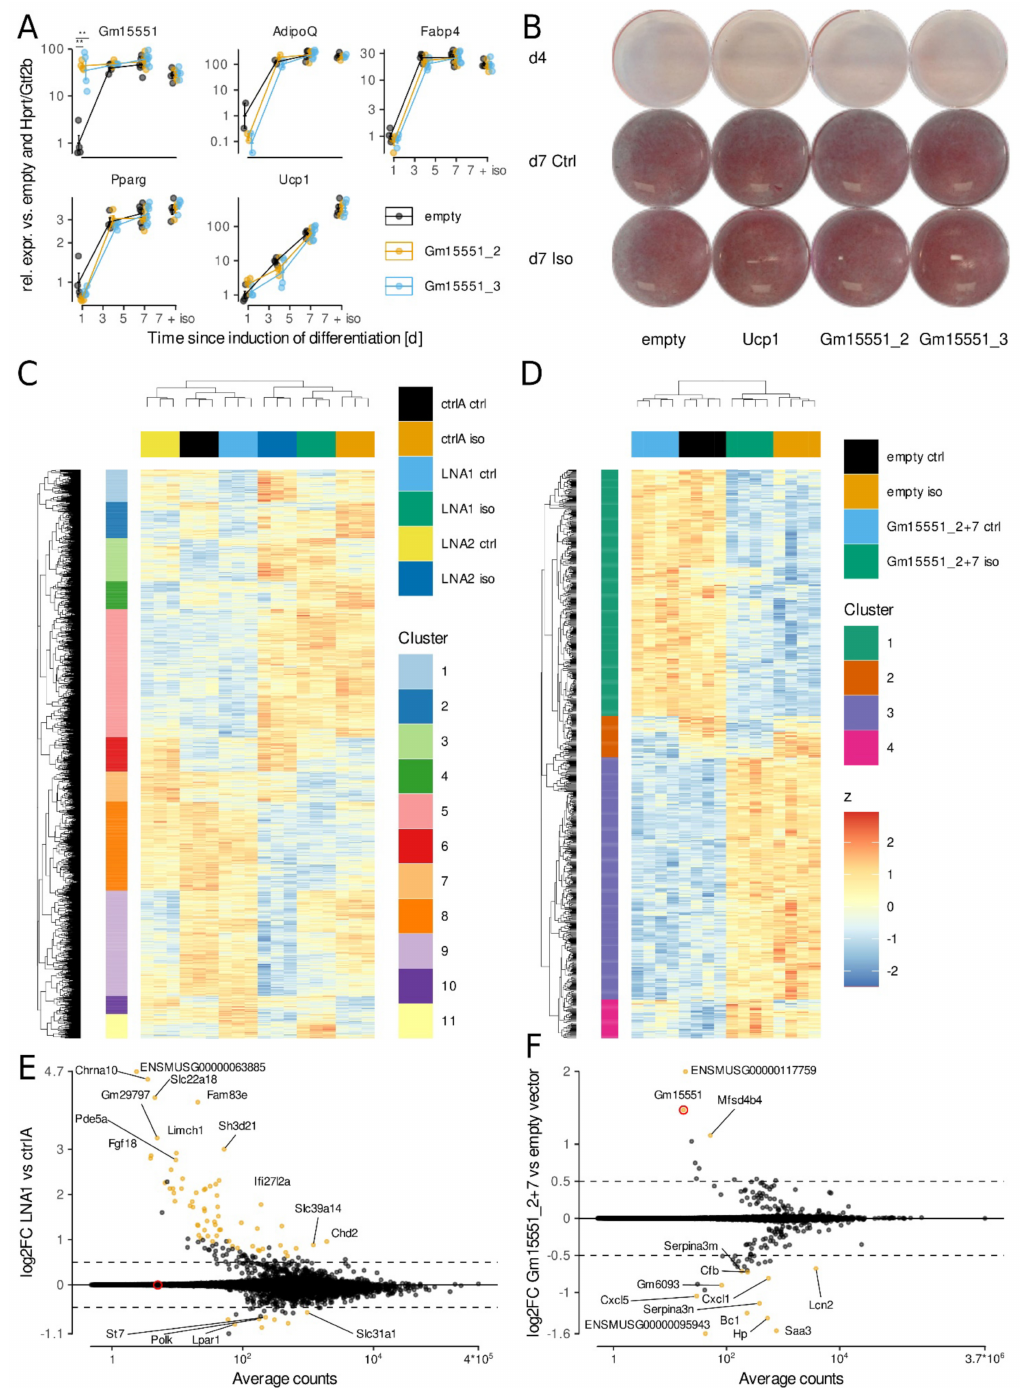
Figure 3. Gm15551 is dispensable for iBAT function in vitro. ( A , B ) Gene expression profiles ( A ) of Gm15551 , the common adipocyte marker genes Pparg , Adipoq and Fabp4 as well as the brown adipocyte marker gene Ucp1 (paired t -test, n = 2–6) and oil red O staining ( B ) of wt1-SAM cells transfected with plasmids coding for sgRNAs targeting Gm15551 , Ucp1 or empty vector two days before induction of differentiation. ( C , D ) Hierarchical clustering of genes differentially regulated by β -adrenergic stimulation and/or knockdown ( C ) or overexpression ( D ) in mature adipocytes at day 4 of differentiation (LRT, n = 3 ( C ) or 4 ( D ), p < 0.001). ( E , F ) Effect of knockdown ( E ) or overexpression ( F ) of Gm15551 on gene expression in mature wt1-SAM cells. The log2FC is the average over the effect in isoproterenol stimulated and control cells (wald test, log2FC > 0.5, n = 6 ( E ) or 8 ( F ), s <